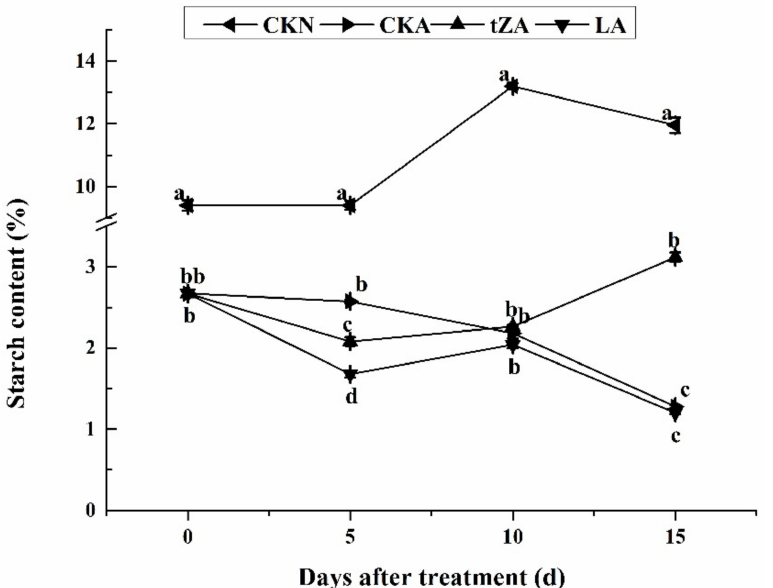
Figure 3. The changes in the starch content in CKN, CKA, tZA and LA groups after treatment. Different lower-case letters among different treatment groups indicate significant differences based on one-way analysis of variance in SPSS 21.0 followed by the Duncan’s test ( p <